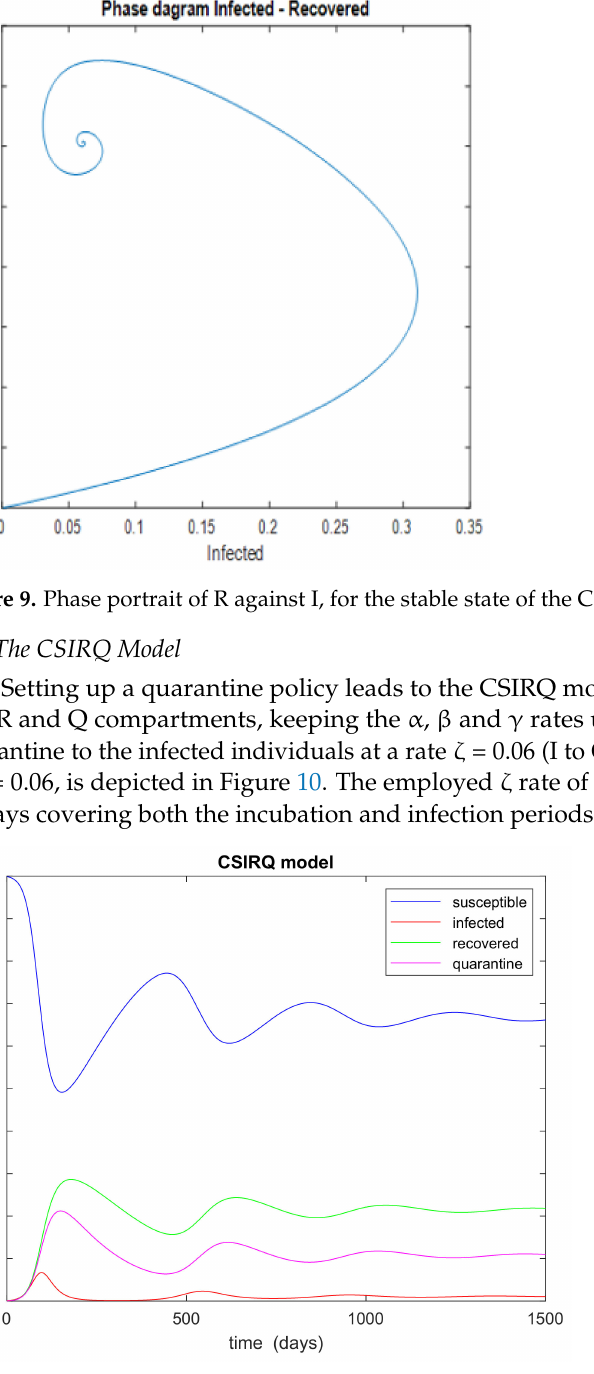
Figure 10. Typical dynamics of the CSIRQ for the following constant rates α = 0.18, β = 0.06, γ = 0.006, ζ = 0.06, ι = 0.006, µ = 0, δ = 0, Cumulative viral load = 5.68 (for t = 365